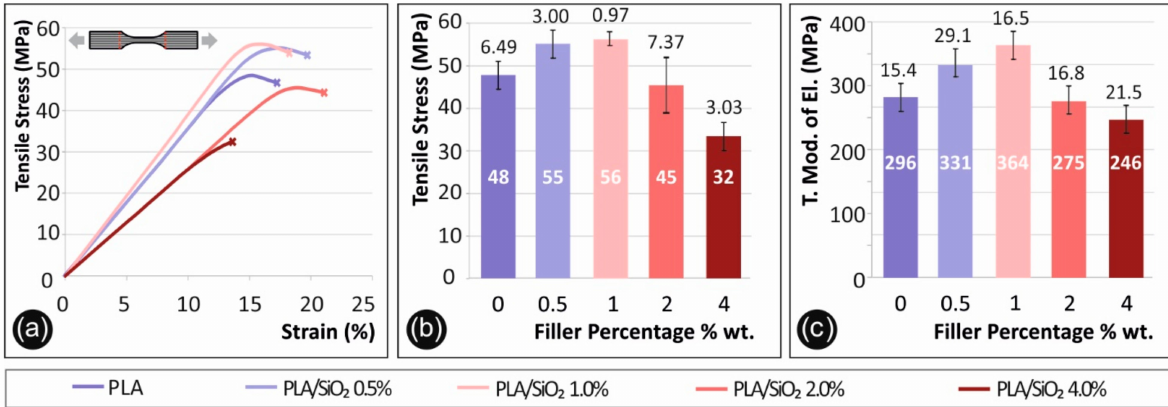
Figure 3. Tensile test results, ( a ) tensile stress (MPa) to strain (%) graph of a representative specimen of each material tested, ( b ) mean max measured tensile stress (at break) (MPa) and standard deviation to filler percentage (%) (0.5% wt. developed 13.8% increased values, when compared to pure Polylactic acid (PLA), 1% wt. 15.6% increase, 2% wt. 6.0% decrease and 4% wt. 33.0% decrease, respectively), ( c ) mean tensile modulus of elasticity (MPa) to filler percentage (%) (0.5% wt. developed 12.0% increased values, when compared to pure PLA, 1% wt. 23.1% increase, 2% wt. 7.2% decrease and 4% wt. 16.9% decrease,